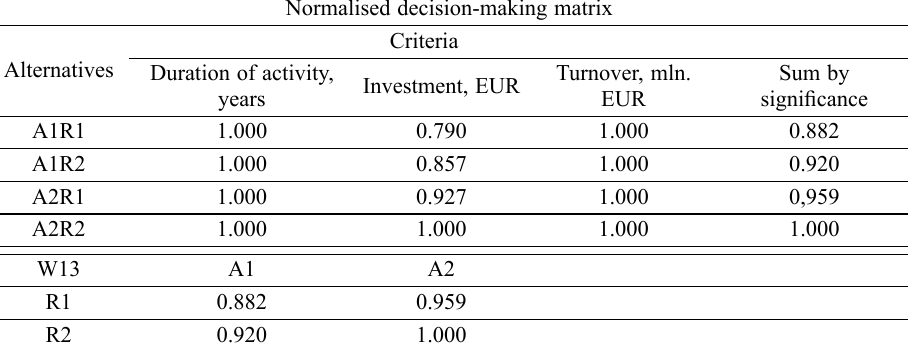
Table A.5. Normalised decision-making matrix (negotiations between the Participant No. 4 and Participant No. 2) Normalised decision-making